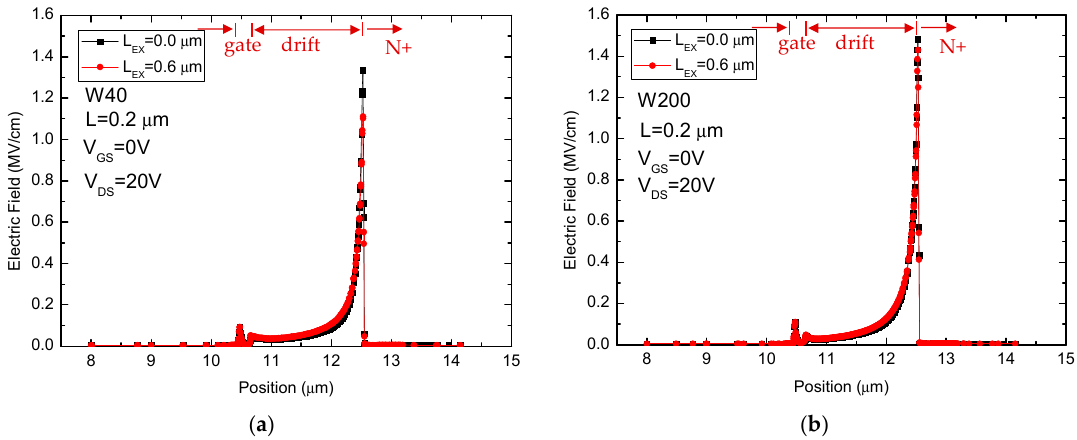
Figure 3. Electric field distribution of ( a ) W40 and ( b ) W200 with L EX = 0 and L EX = 0.6 μ m at V DS = 20 V (before breakdown).